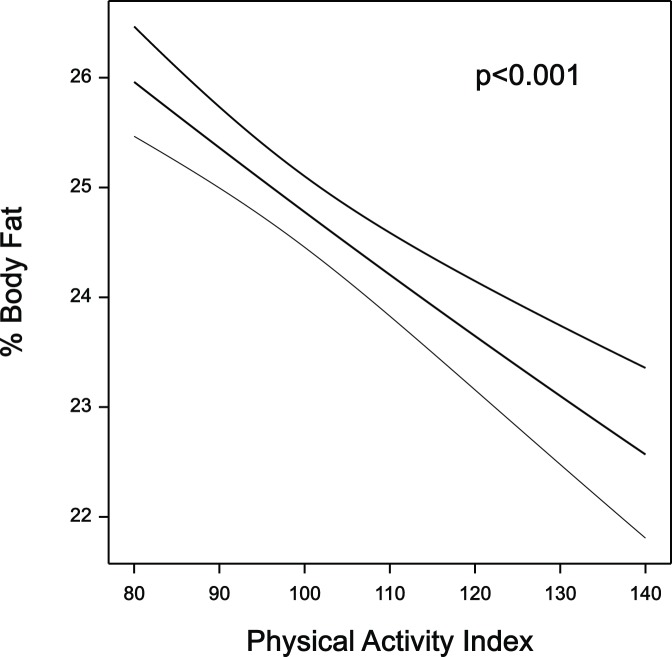
The cross-section relationship, with 95% confidence intervals, between %BF and the physical activity index (approximately the square root of average number of steps per day) for boys and girls, combining data from all three measurement periods.